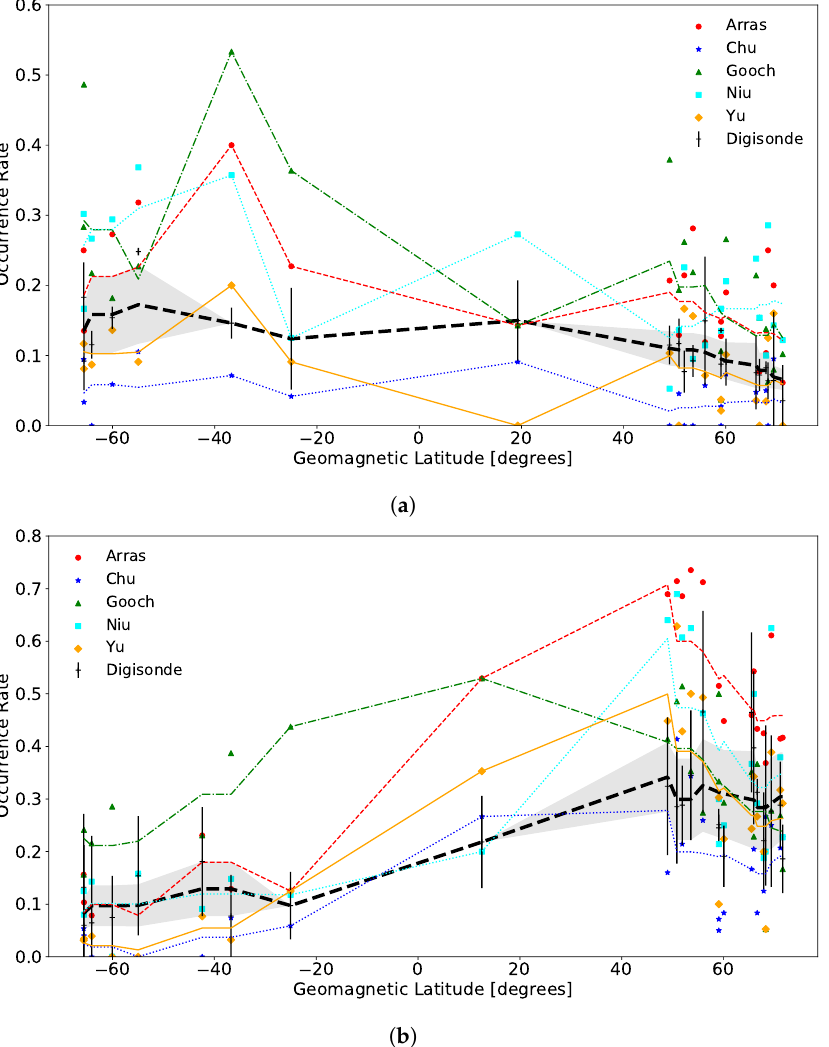
Figure 3. Total occurrence rates with no lower limit on E s intensity as a function of latitude with spatial rolling averages calculated using a ± 10 ◦ window for trendlines. Shading around the Digisonde trendline (black dashed line) represents a rolling standard deviation of the Digisonde ORs with a ± 10 ◦ latitude window. Ionosonde error bars are calculated from a standard deviation taken over 2010–2017 using the OR from each year as a separate data point. Note the change in scale between the two figures. ( a ) December, January, and February 2010–2017. ( b ) June, July, and August